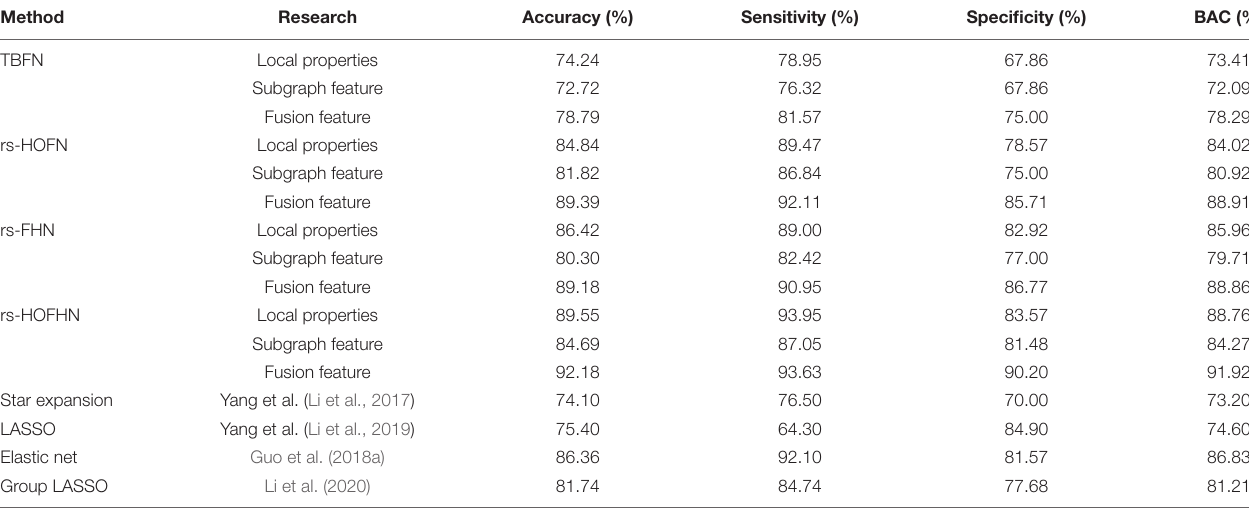
TABLE 3 | Comparison of classification results for different